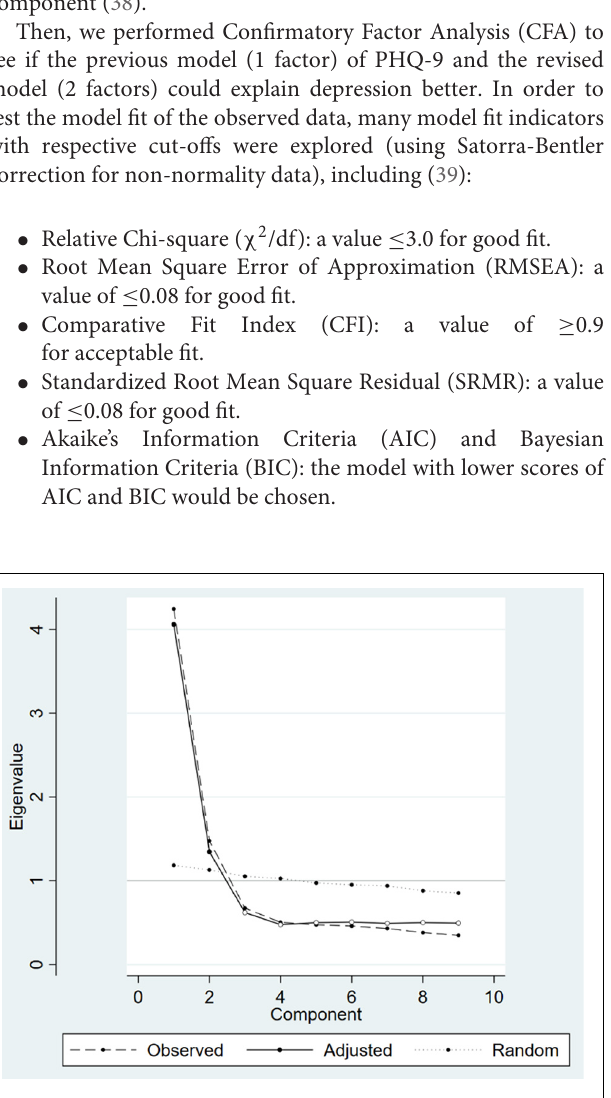
FIGURE 1 | Scree plot and parallel